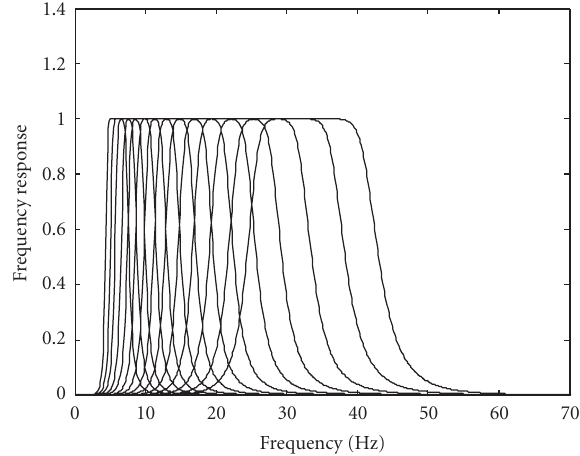
Figure 2: Frequency responses of constant- Q filters ( Q = 2), 14 center frequencies are between 6 to